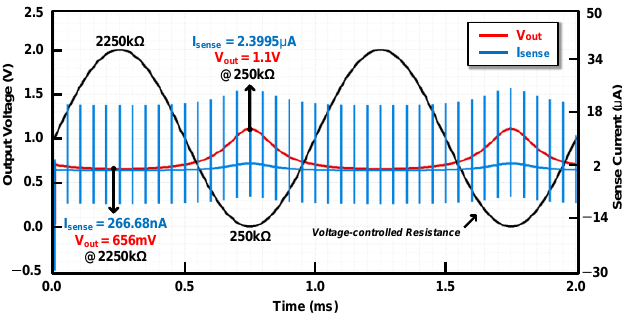
Figure 7. Simplified electrical equivalent model of the glucose monitoring biosensor.